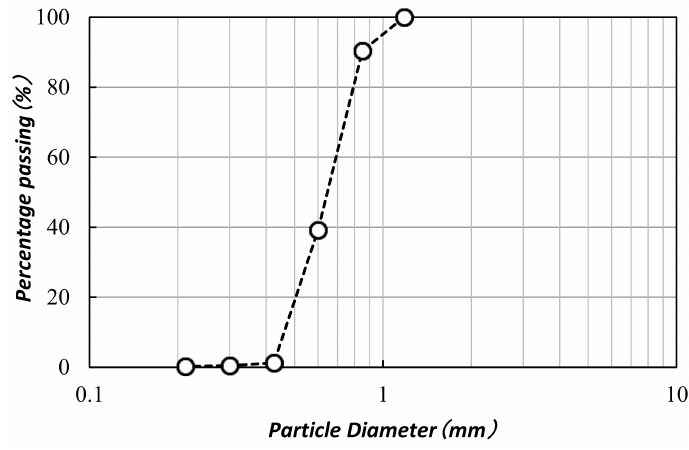
Figure 1. The granulometry of the Mikawa sand used in this study.